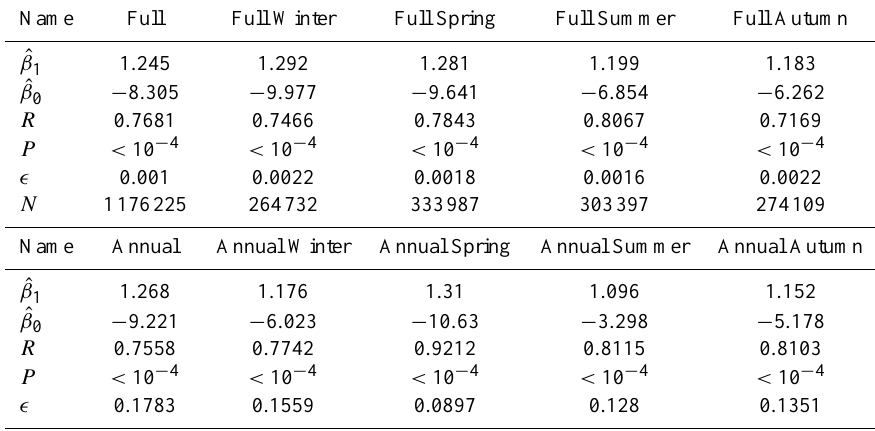
Table 2. Linear regression output parameters for